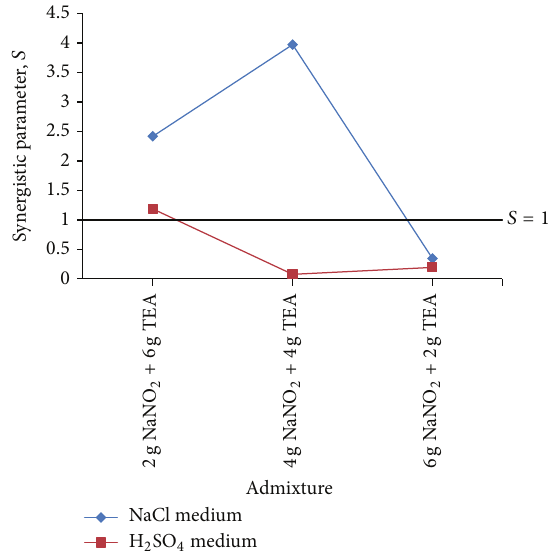
Figure 5: Synergistic interaction modelling NaNO 2 and C 6 H 15 NO 3 (TEA) admixtures on steel-rebar